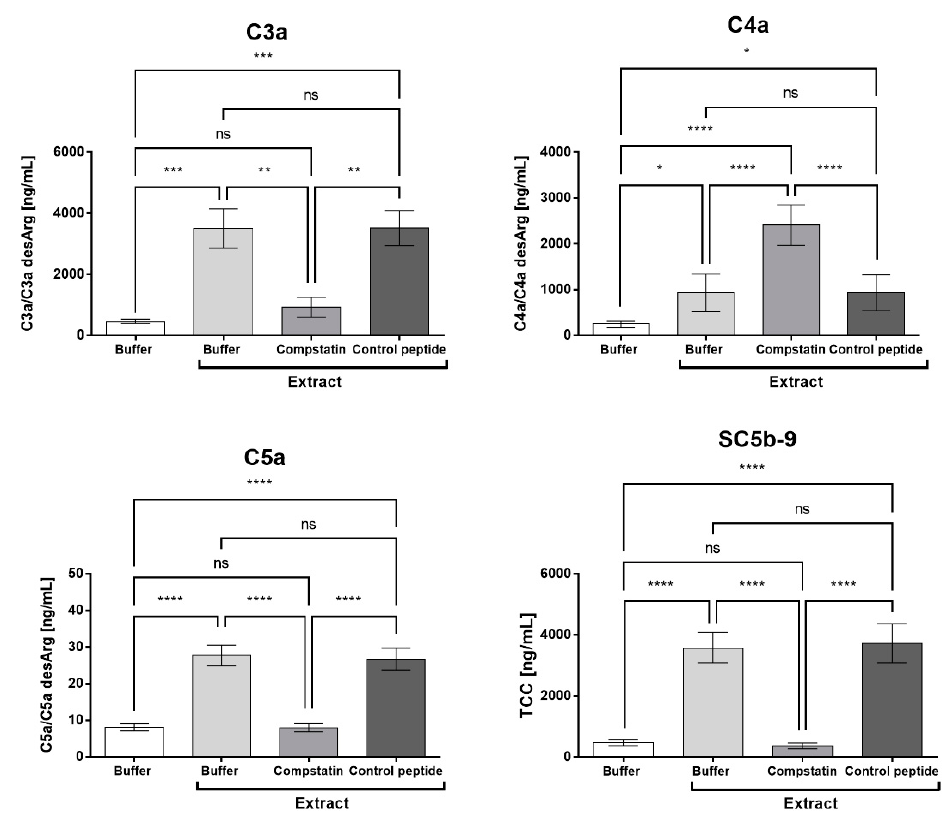
Figure 4. Production of anaphylatoxins and the terminal complement complex in whole blood stimulated with Pararama hair extract in the presence of compstatin. Human blood samples anticoagulated with lepirudin (50 µ g/mL) were preincubated with PBS, compstatin (50 µ M), or control peptide (50 µ M) and then incubated with Pararama hair extract (95 µ g/mL) or PBS for 30 min at 37 ◦ C. After plasma collection, anaphylatoxin (C3a, C4a, and C5a) generation was assessed by flow cytometry, and SC5b-9 production was assessed by ELISA. The results are presented as the mean ± SD of three independent experiments. * p : < 0.05. ** p : < 0.01. *** p : < 0.001. **** p : < 0.0001. ns: not significant.